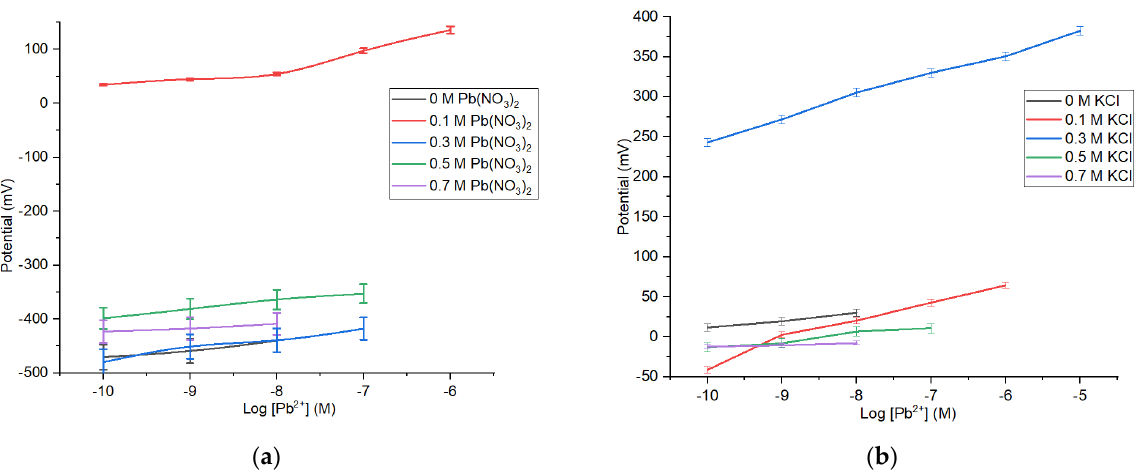
Figure 4. Profile of Pb 2+ ISE sensitivities and linear ranges on the variation of internal solution Pb(NO 3 ) 2 ( a ) and KCl ( b ).